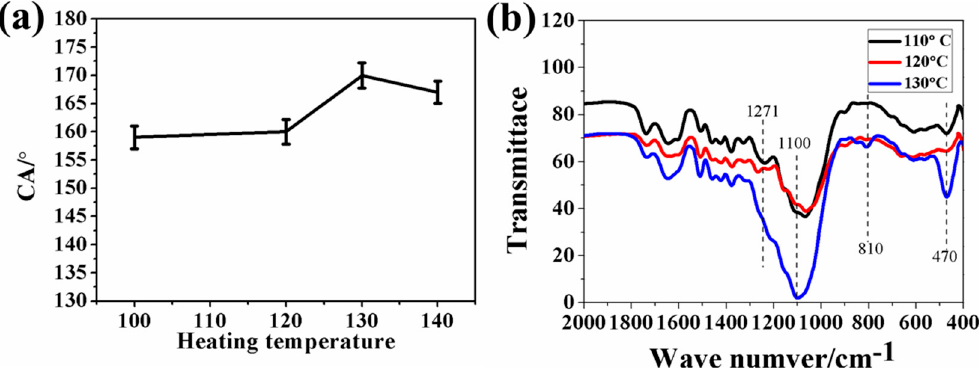
Figure 4. ( a ) The water contact angles (Cas) of the surfaces of coated sanded wood obtained at different drying temperatures, ( b ) Comparison of FTIR spectra of sanded woods coated with KH1322 fluoroalkylsilane and silica obtained at different drying temperatures.